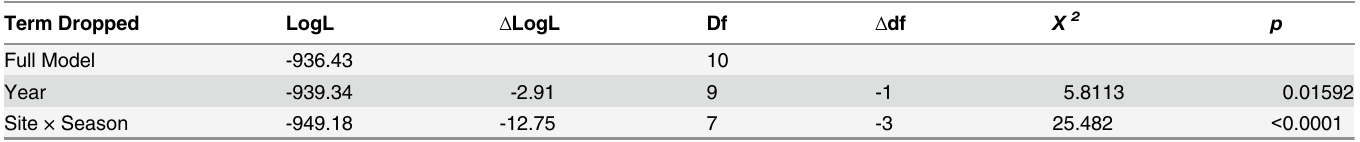
Table 1. Summary of final model results of Pocilloporidae spat settlement at Kusu and Raffles Lighthouse, evaluated by likelihood ratio tests of nested models.